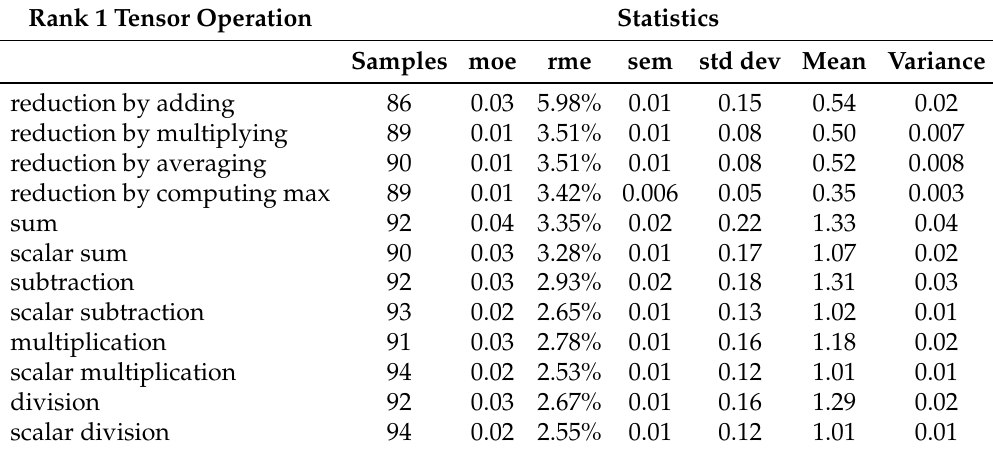
Table 17. Raspberry Pi IV benchmark statistics for rank 1 tensor operations with k = 32 (times in